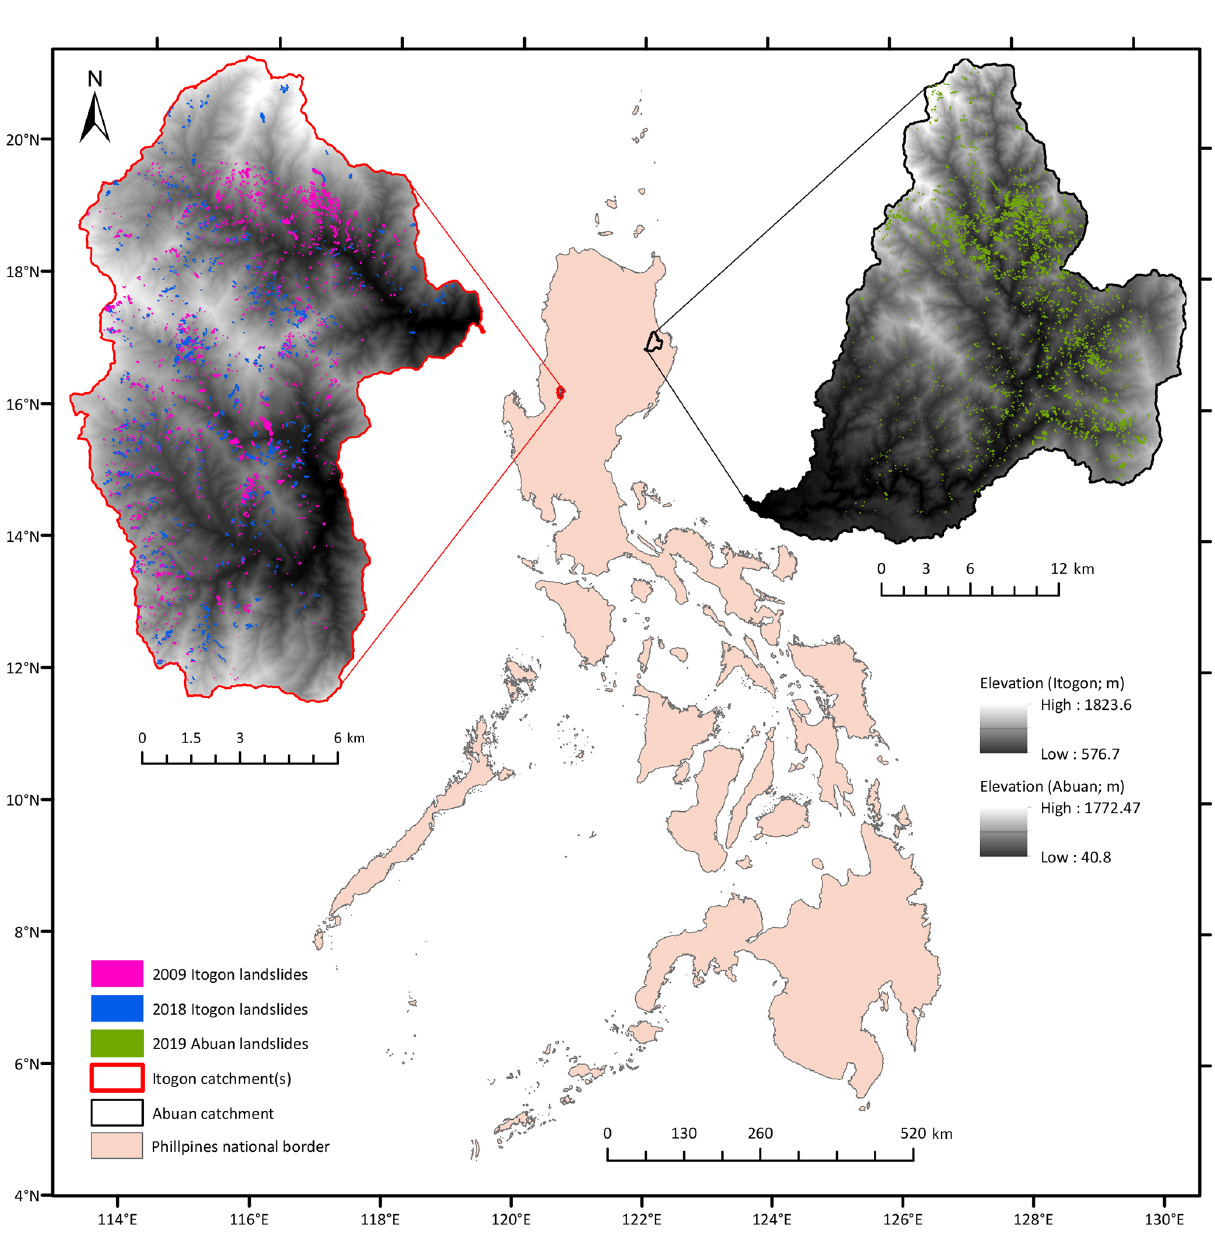
Figure 2. Locations of the two study regions, including the three landslide inventories used throughout this